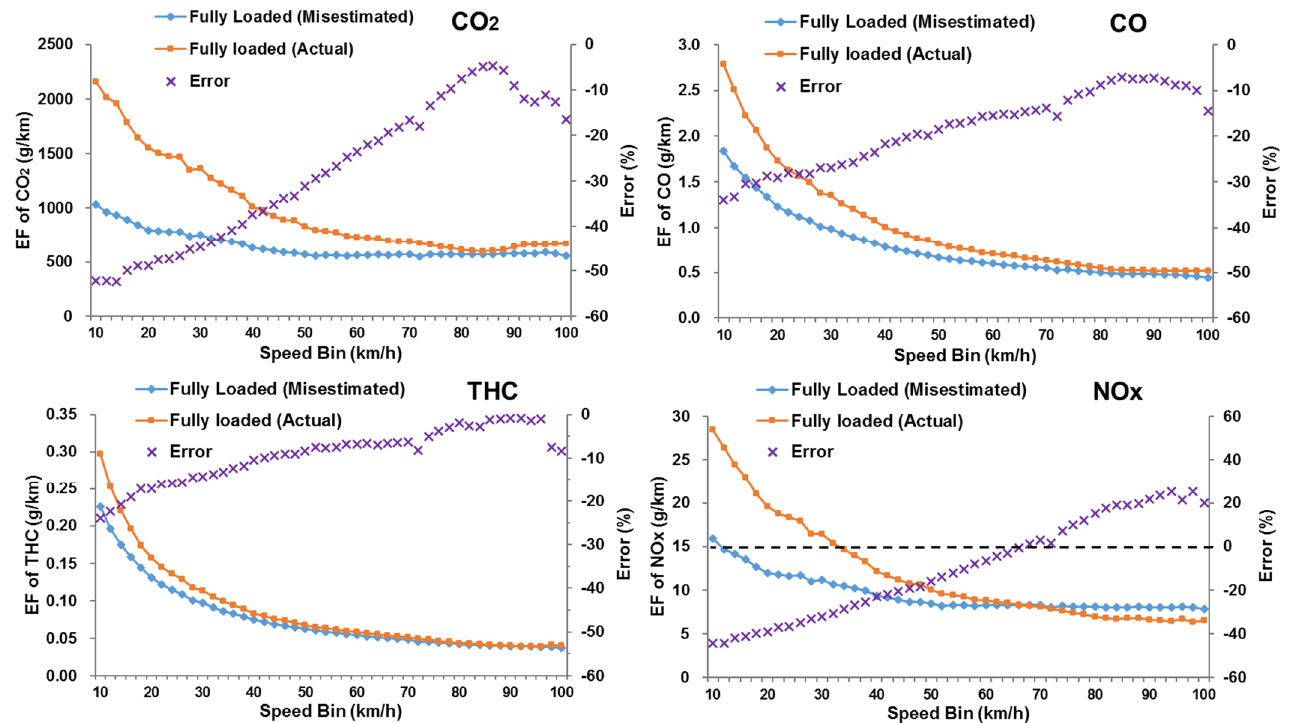
Figure 9. The emission factor differences of CO 2 , CO, THC and NO x between fully loaded and misestimated-fully loaded status in each speed bin. (emission factor of misestimated-fully loaded states was obtained by calculating the STP distribution using the m of unloaded trucks and combining with the emission rate of unloaded trucks.).